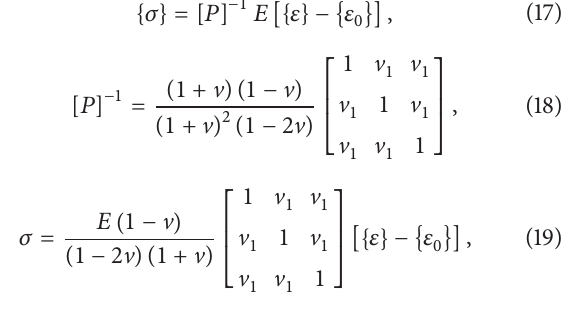
Figure 6: Heat flow pattern for four different load cases.